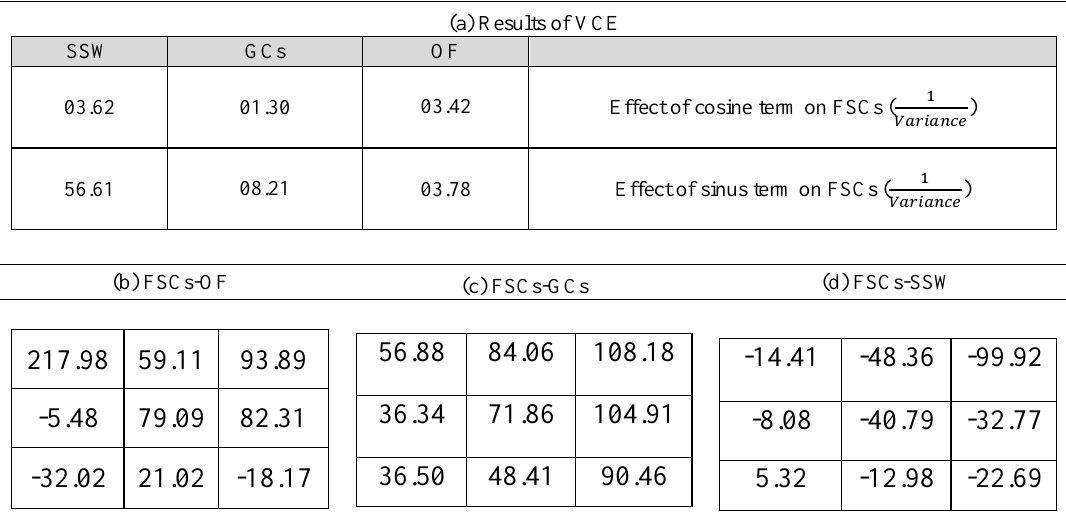
Tables b, c and d are respectively Angular differences between FSCs and OF, GCs and SSW (in